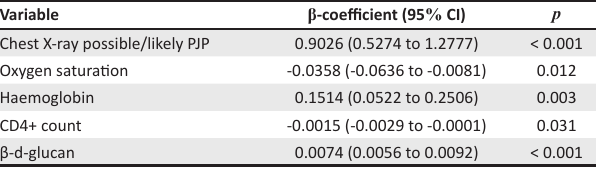
TABLE 2: The final multivariable model of predictors of Pneumocystis jirovecii copy number on sputum real-time polymerase chain reaction used for imputation. Variable